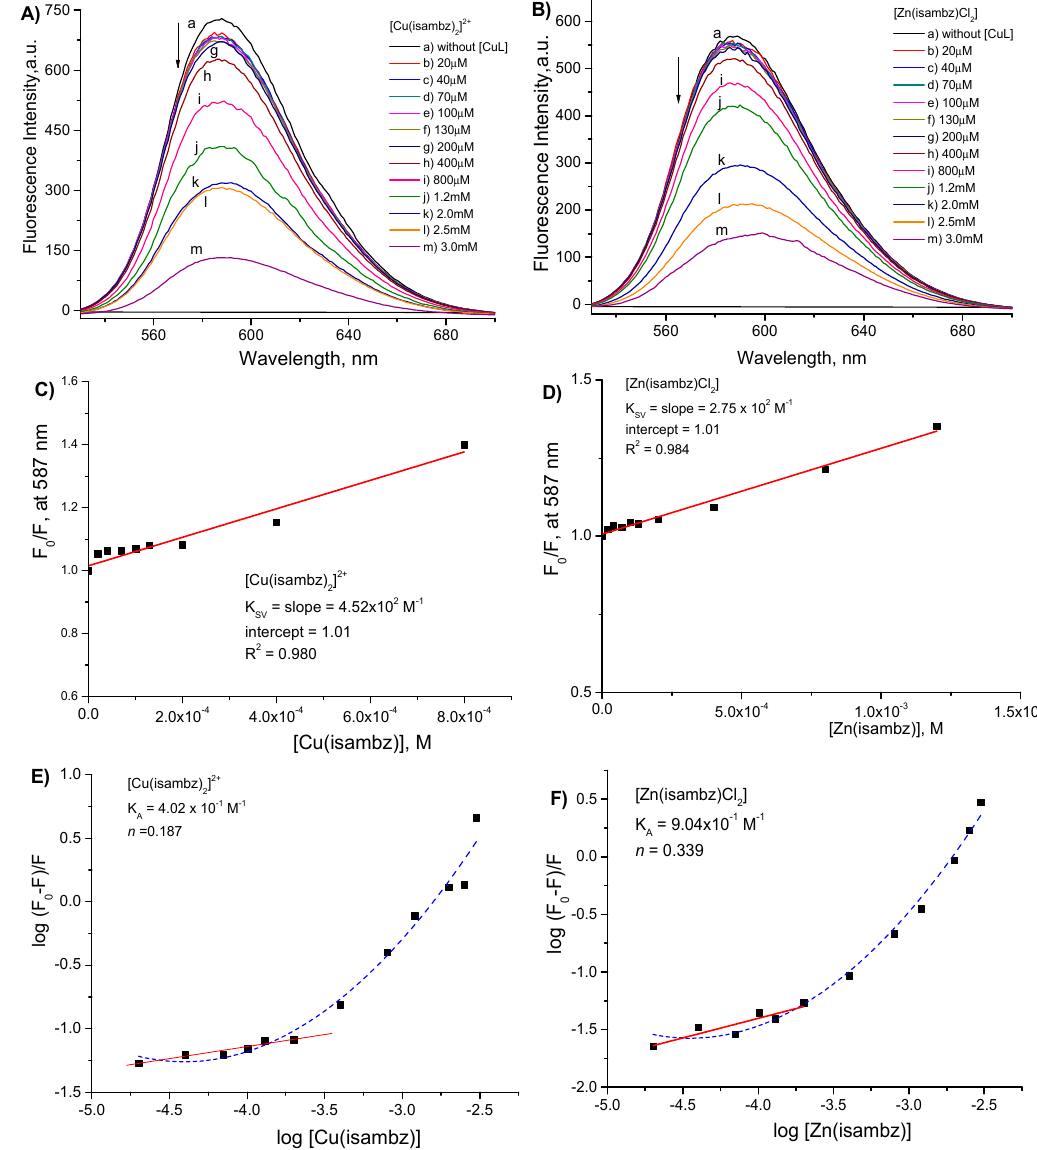
Figure 5. ( A , B ) Fluorescence emission spectra of EtBr intercalated to CT-DNA, in the absence and in the presence of the complexes [Cu(isambz) 2 ] 2+ 1 or [Zn(isambz)] 2+ 2 , respectively. [EtBr] = 50 µ M; [CT-DNA] = 30 µ M, and quencher concentration varying from 20–3000 µ M; ( C , D ) Stern–Volmer equation dependence on the concentration of quenchers, complexes [Cu(isambz)] 2+ 1 or [Zn(isambz)] 2+ 2 , respectively; ( E , F ) Scathchard plots and linear regression fittings to estimate association binding constants, and corresponding binding site number for quenchers, [Cu(isambz) 2 ] 2+ 1 or [Zn(isambz)] 2+ 2 , respectively.